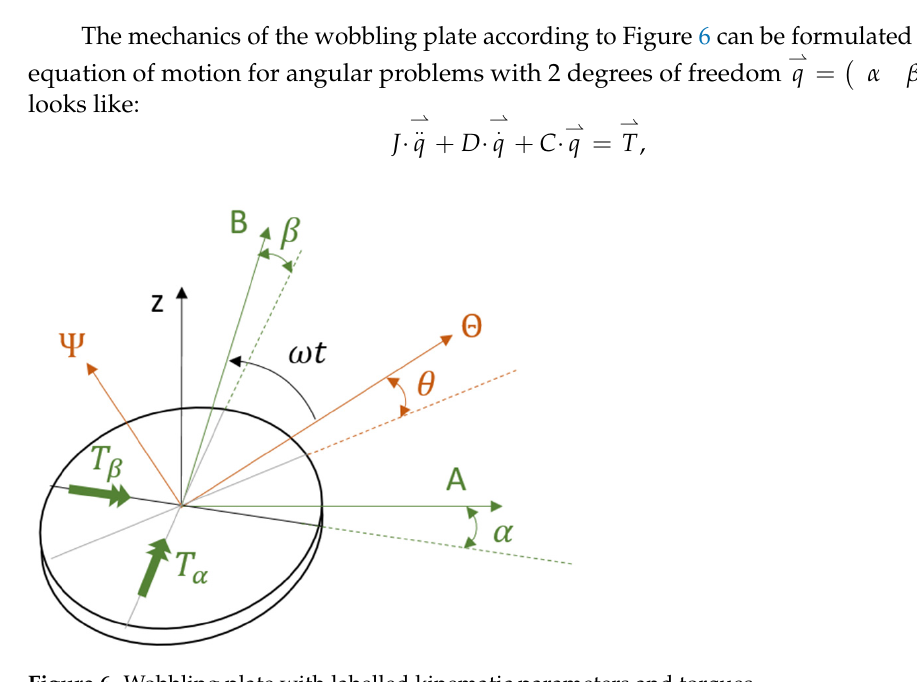
( b ) Figure 7. Analogous model of the complex pump system regarding the dynamic film on the contact area: ( a ) illustration of the simplified wobble situation; ( b ) principal abstracted scheme. This dynamic fluid gap is influenced by the stiffness of the rubber, the occurring fluid pressure and the wobbling speed of the pump itself. A phenomenological mechanical model based on this system is illustrated in Figure 8. The rubber was described by the well-known Kelvin–Voigt model [20] (parallel connection of elastic spring and viscous damper).